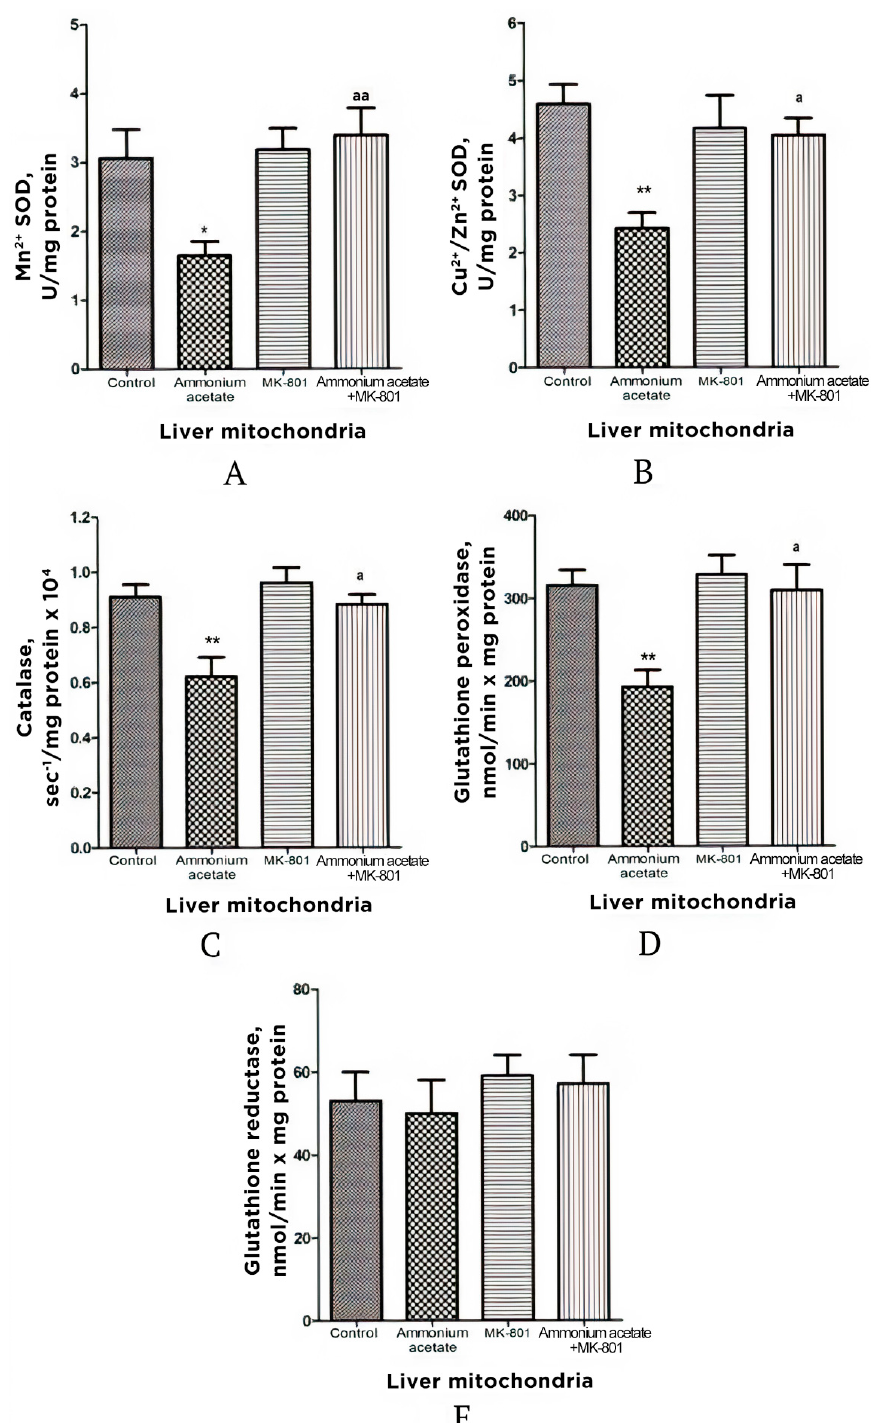
Figure 4. Activities of antioxidant enzymes superoxide dismutase (Mn 2+ ( A ) and Cu 2+ , Zn 2+ ( B ) isoforms), catalase ( C ), glutathione peroxidase ( D ), and glutathione reductase ( E ) in liver mitochondria of animals in different experimental groups. Experimental design was the same as in Figure 1 legend. The enzyme activity was measured as indicated in Materials and Methods. All data are shown as mean ± SEM. Values significantly different from the control group are designated with one (*) and two (**) asterisks: * p < 0.05, ** p < 0.01 (Student’s t -test). a significant differences when compared with ammonia group. a p < 0.05, aa p < 0.01 (with the Bonferroni correction for multiple